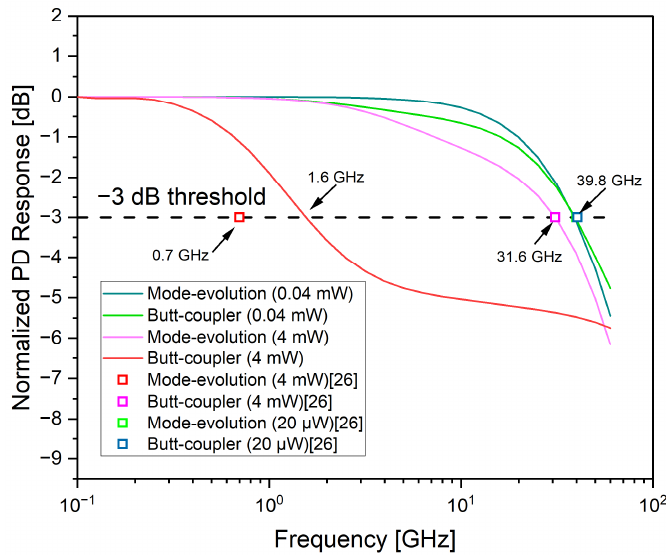
Figure 3. Simulated frequency response of the proposed mode-evolution-based coupled detector and the conventional butt-coupled detector at 40 μW and 4 mW total input power. The 3 dB band- width of both structures reported in the literature [26] are marked with boxes in the figure. The green box and the blue box almost coincide, so only the blue box can be seen in the